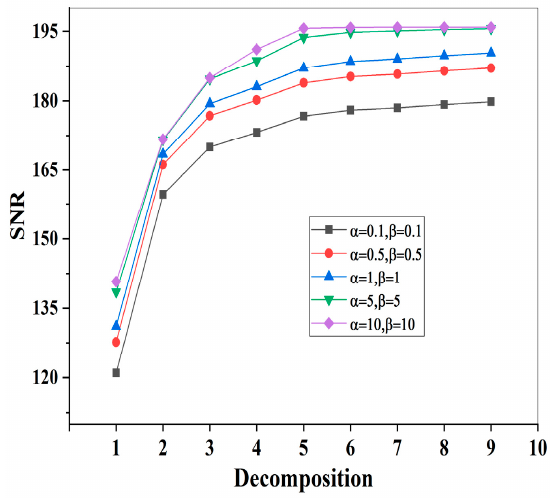
Figure 8. SNR under different decomposition levels.